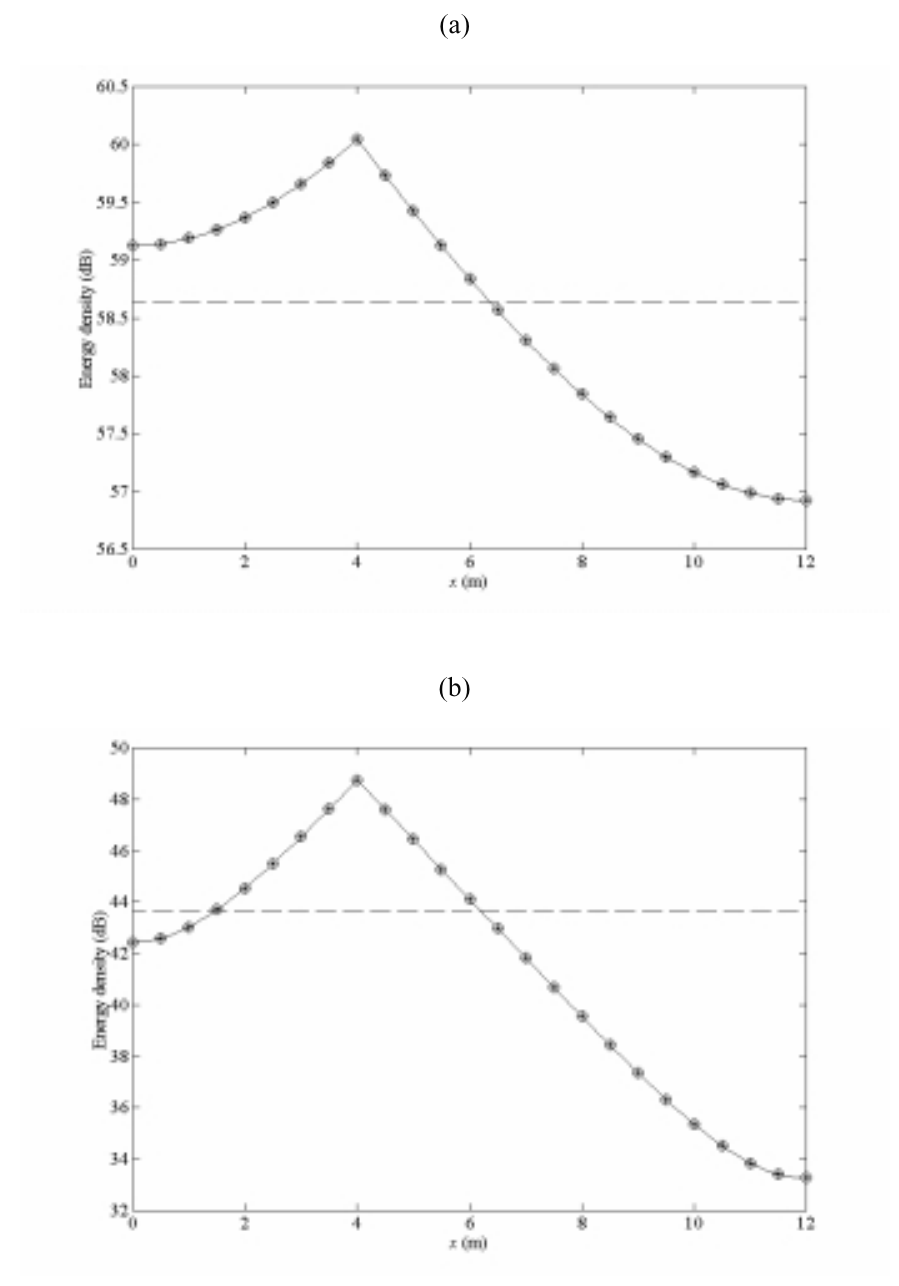
Fig. 2. Comparisons of energy density distributions in beam when η = 0 . 02 . The reference energy density is 1 × 10 − 12 J/m 2 ; (a) f = 1 kHz, (b) f = 10 kHz: —, EFA; - - -, SEA; , direct EFBEM; , indirect